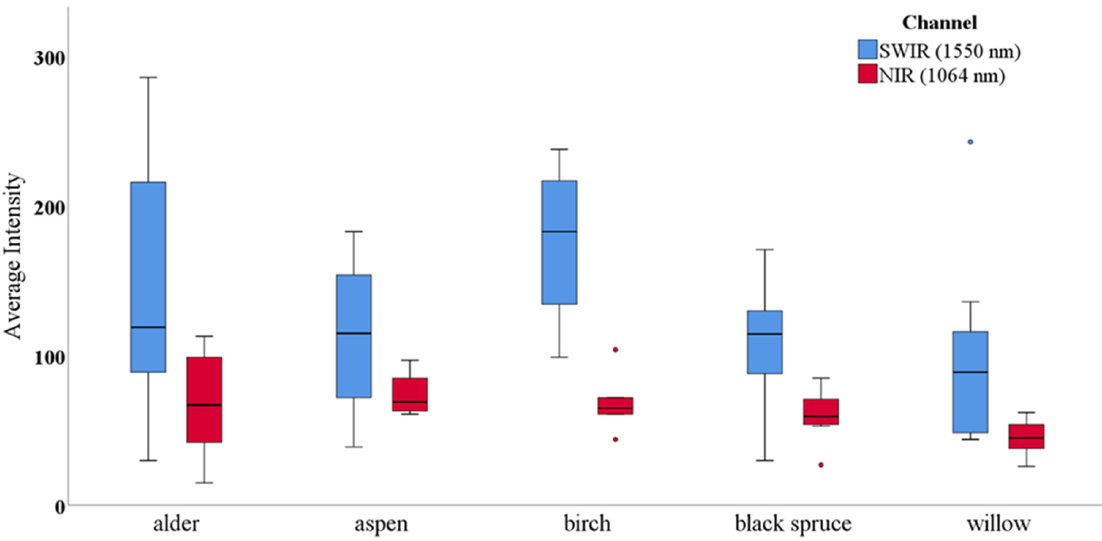
Figure 5. Average SWIR (shortwave infrared, 1550 nm) and NIR (near infrared, 1064 nm) intensities for field-identified, unmixed pixels with deciduous and conifer species using all returns of SWIR and NIR > 0.5 m ( n = 44).